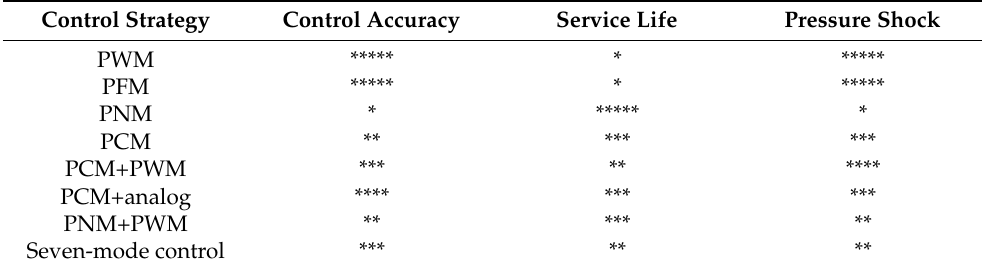
Table 2. Comparison of control strategies performance for parallel